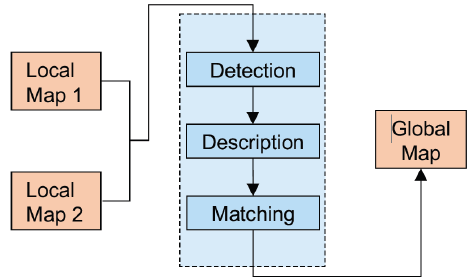
Figure 2. Map merging based on image feature matching.